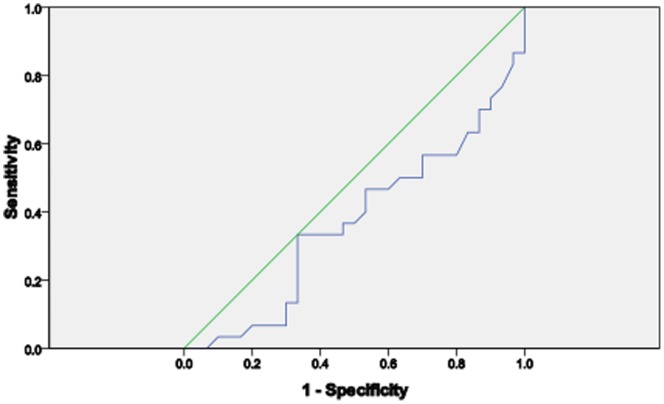
The ROC curve of CRP in SCA subjects.